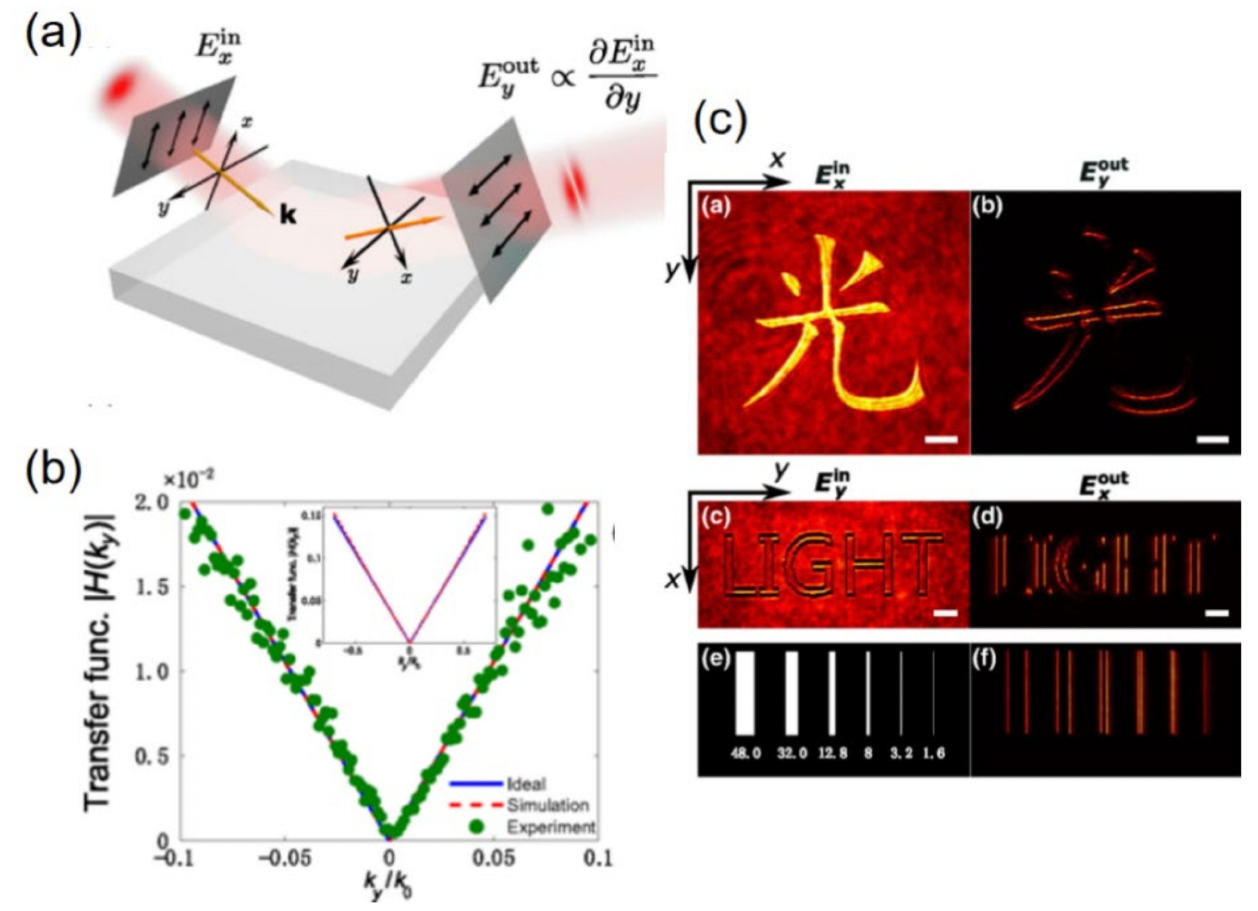
Figure 12. ( a ) Schematic of spatial differentiation from the SHE of light on an optical planar interface between two isotropic materials; ( b ) the comparison of theoretical and experimental results for the spatial spectral transfer function for k x = 0; ( c ) the results of edge detection with different target images stored in E in x and E in y , respectively. Adapted with permission from [150], APS,